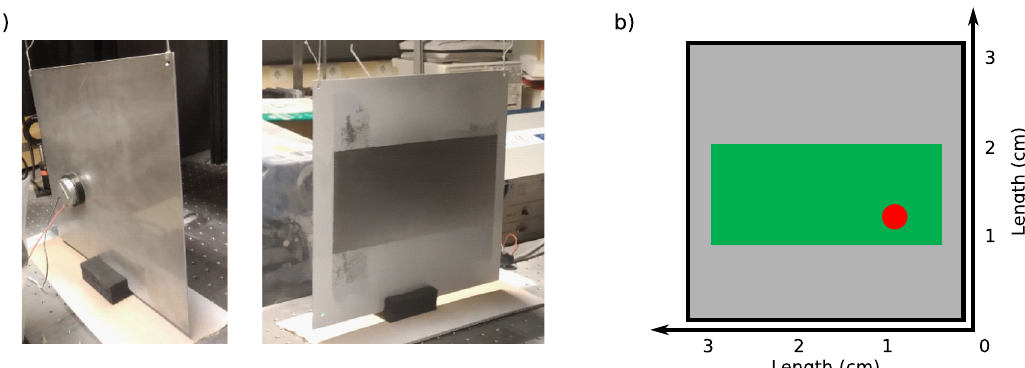
Figure 6. (a) Photographs of the set-up with the plate clamped to the bench and the mechanical shaker, (b) scheme of the plate, green is the zone measured by holography and red spot indicates the location of the excitation